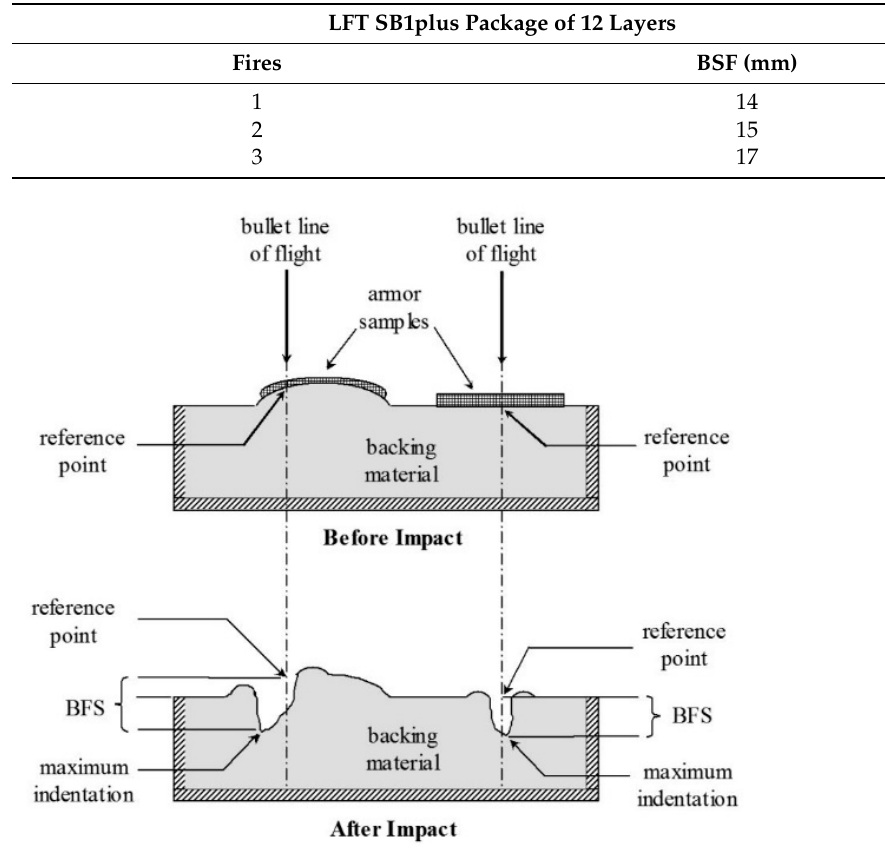
Table 1. BFS of a ballistic package made of LFT SB1plus layers.